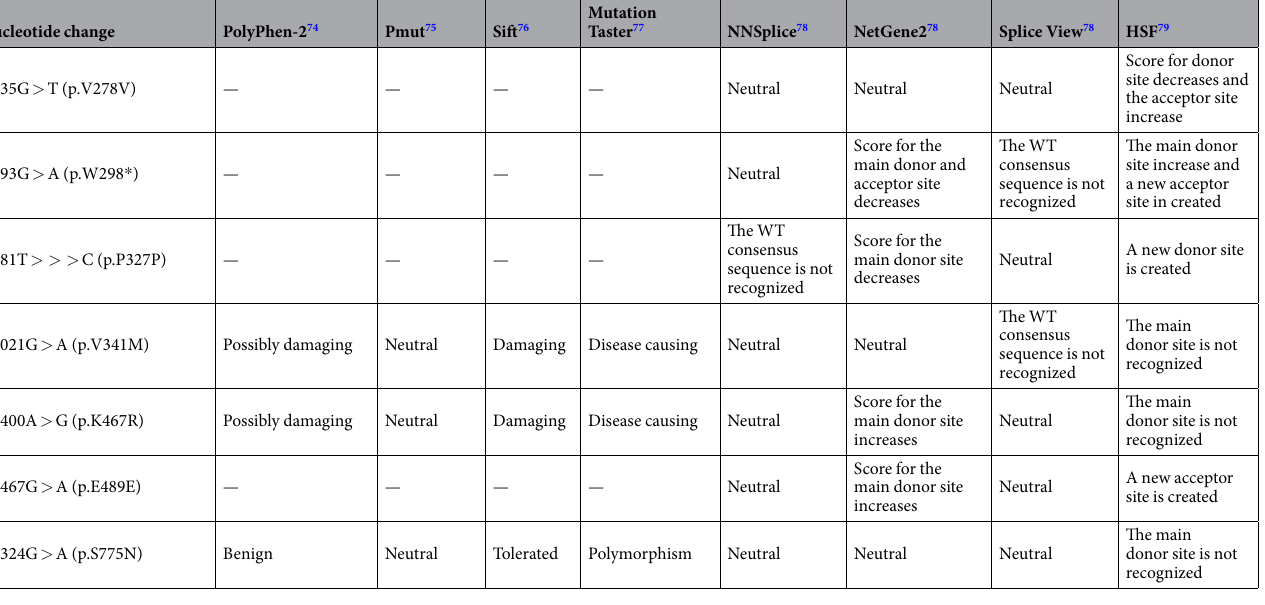
Table 2. In silico analysis of variants identify in the BMPR2